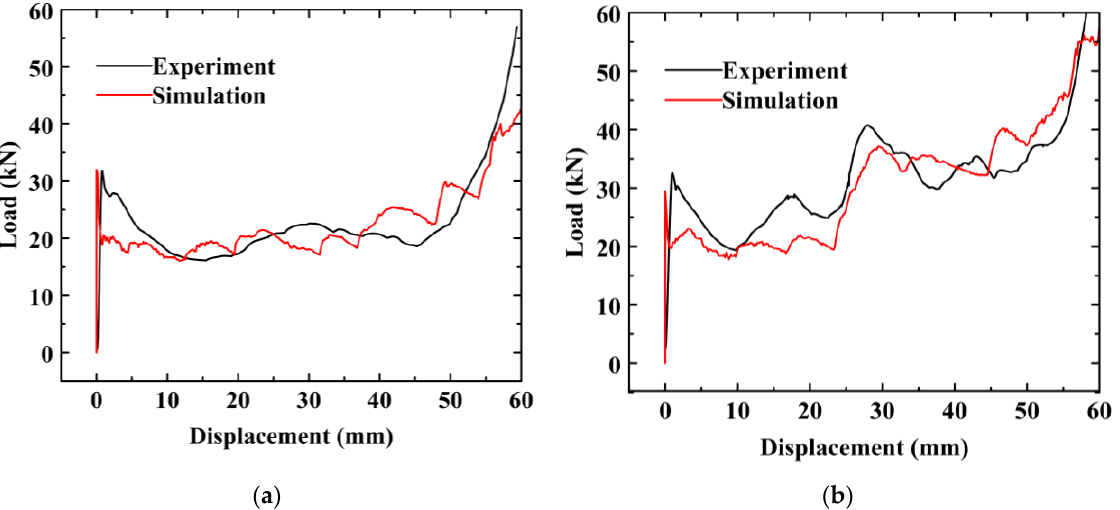
Figure 10. Comparison of load – displacement relation for foam-filled thin-walled tubes: ( a ) FUT and ( b ) FLNT-2. Table 7. Error analysis of energy absorption between FE solutions and experiment.